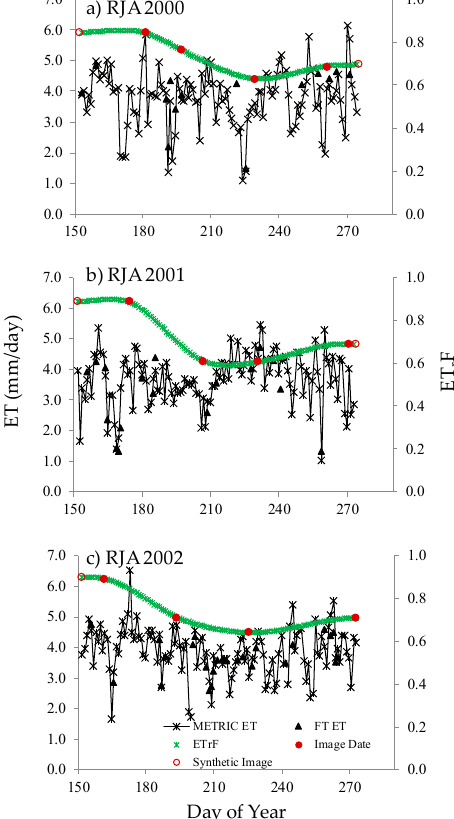
Figure 7. ( a – c ) Daily ET r F interpolated by a spline function with image dates (closed circle), daily ET